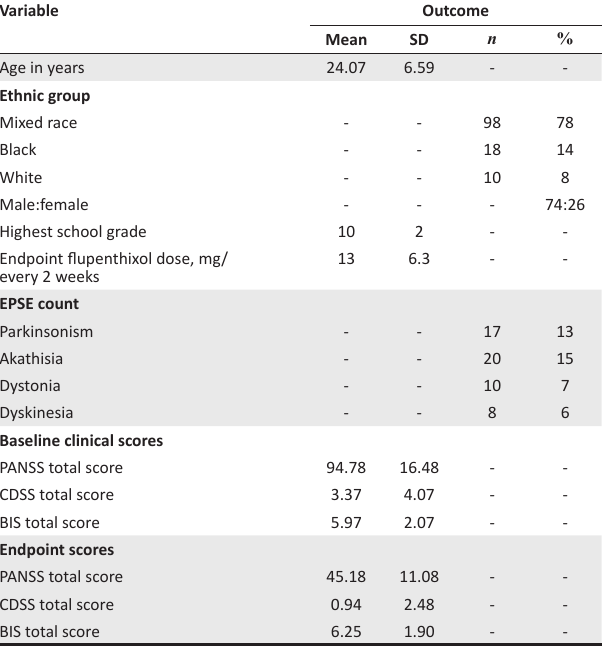
TABLE 1: Demographics and clinical features of participants with first-episode schizophrenia ( N = 130). Variable